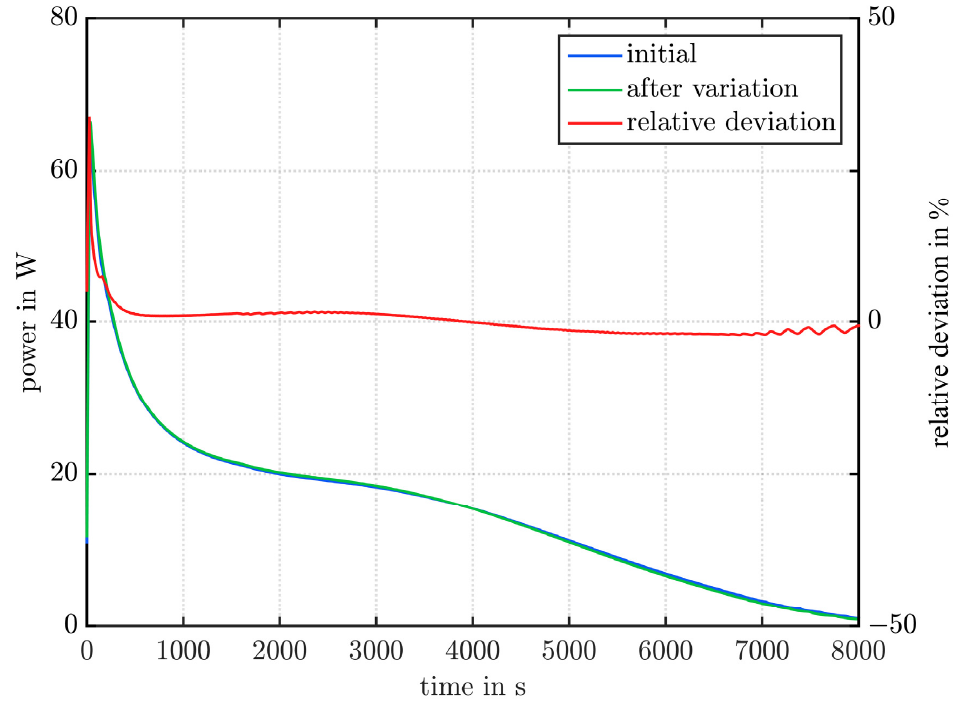
Figure A5. Power over time curve for charging of the standard case and the case with an increased inlet velocity as well as the regarding relative deviation.